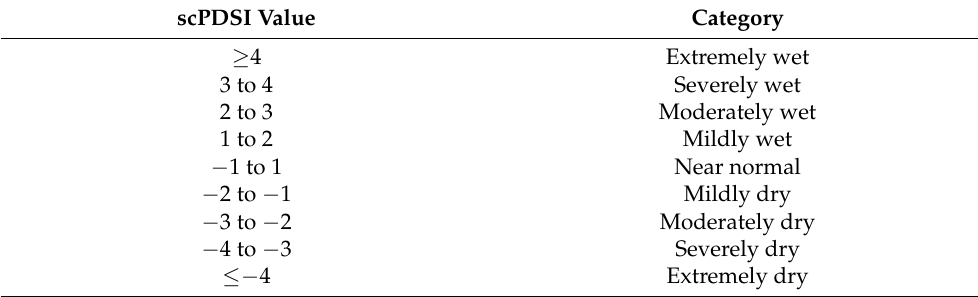
Table 1. Drought categories according to scPDSI